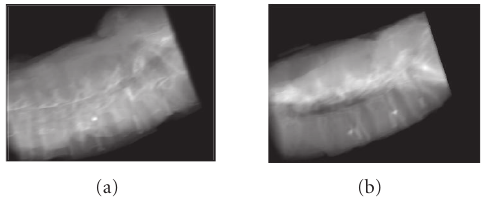
Figure 7: Two projections of the CT volume. According to the out- come of our registration procedure, these projections correspond to the C-arm images given in Figure 6. As the DRB was not present at the time the CT was acquired, it is not present here. The fiducial markers, however, are present at all times.